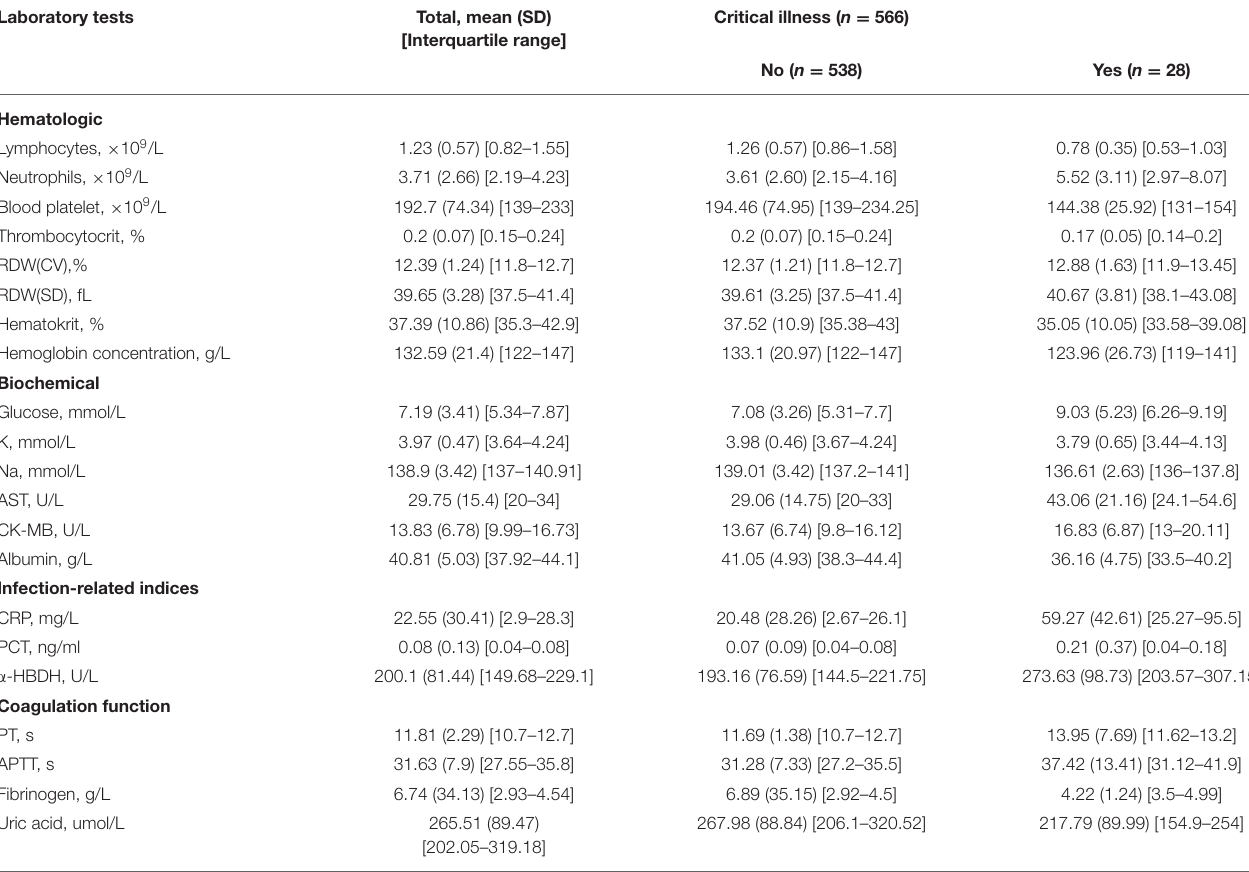
TABLE 3 | Laboratory characteristics of patients with COVID-19 in validation